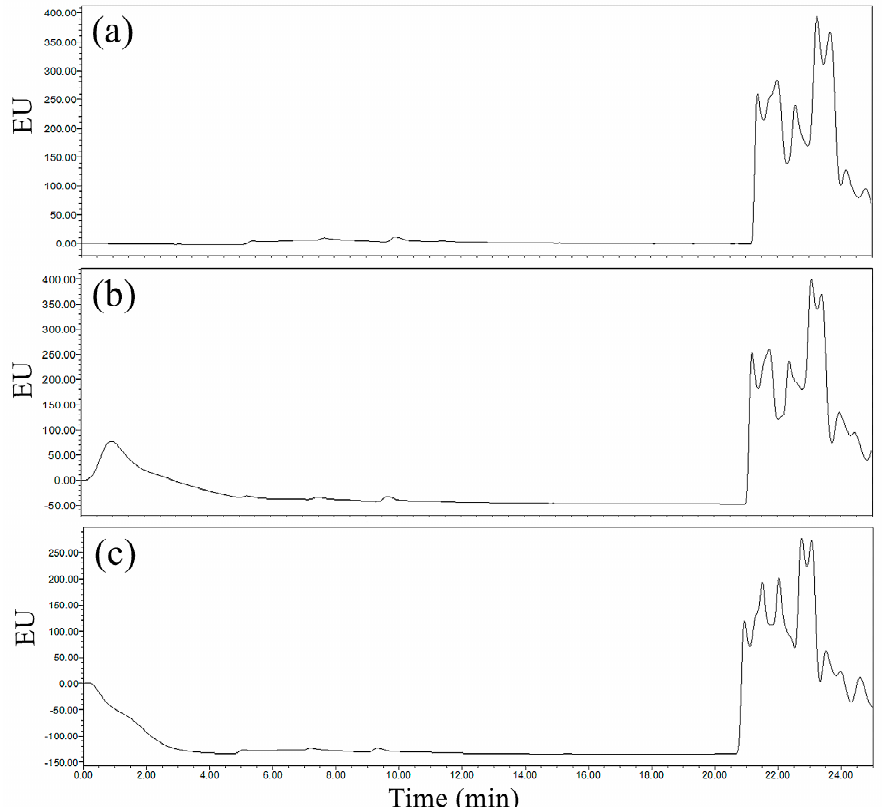
Figure 8. Chromatograms of the RP-C 18 column for the ( a ) sample derived from the blank control, ( b ) sample derived from the 0.1 mg/L GLUF-P matrix solution, and ( c ) sample derived from the 0.5 mg/L GLUF-P matrix solution.